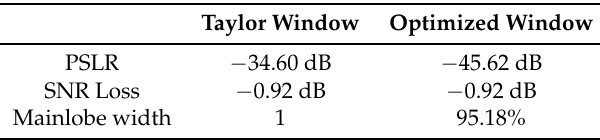
Table 1. Comparison between output parameters of Taylor window (¯ n = 6,PSLR = − 35 dB) and